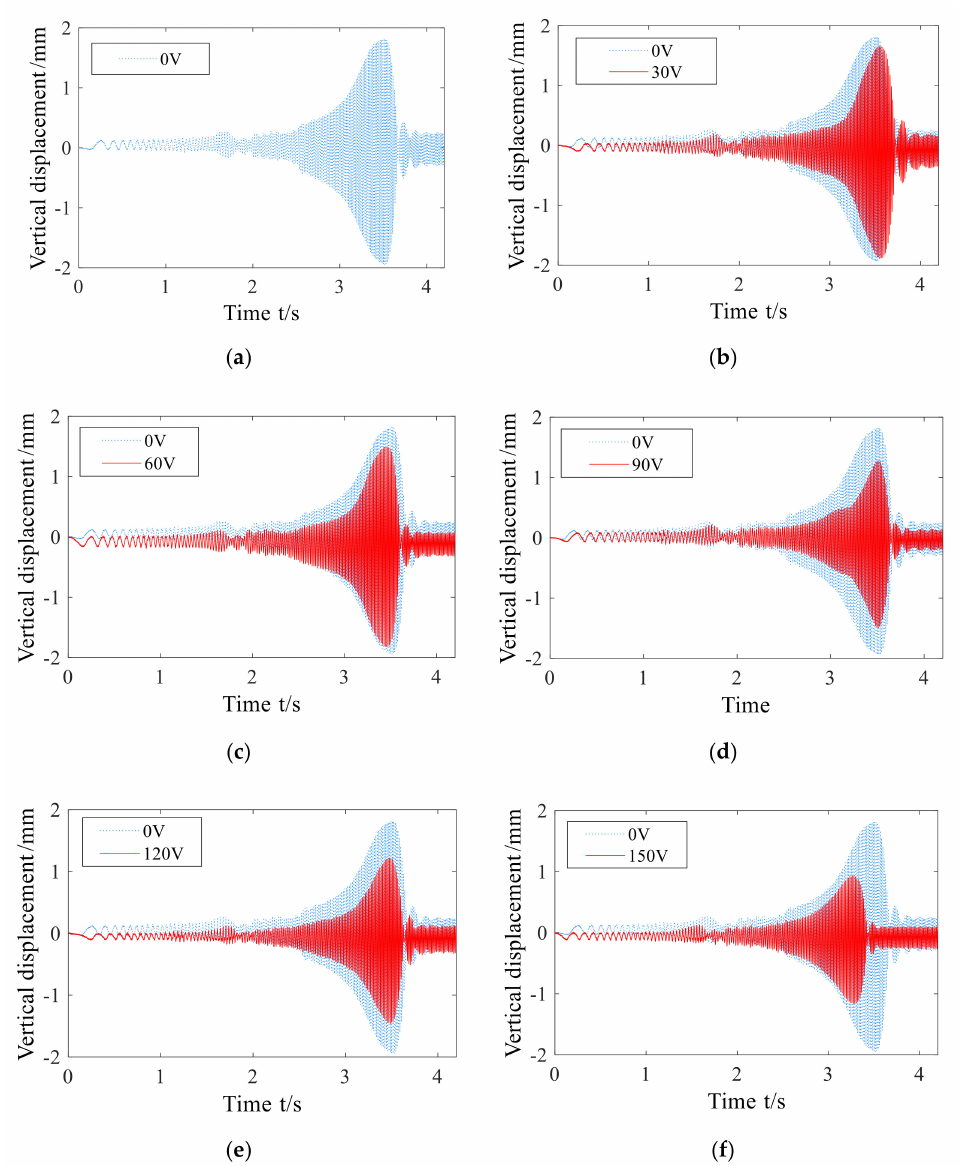
Figure 13. Accelerated over-critical vibration response of shafting under ( a – f ) control voltages, respectively 0 V, 30 V, 60 V, 90 V, 120 V and 150